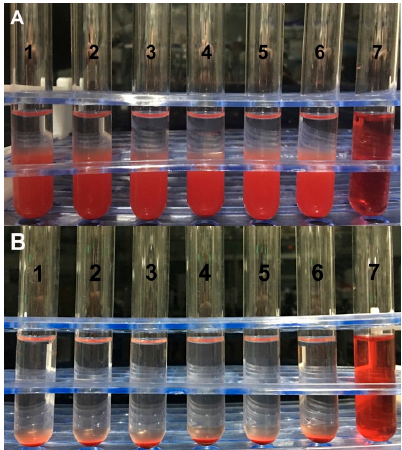
Figure 8. Photographs of the anti-hemolysis of RBGPs with different concentrations. ( A ) represents 3 h of incubation at 37 °C, ( B ) represents 24 h of incubation. The concentrations of RBGPs were 2% (1), 4% (2), 6% (3), 8% (4), and 10% (5). Tube 6 was from the physiological saline group and tube 7 was from the distilled water group.